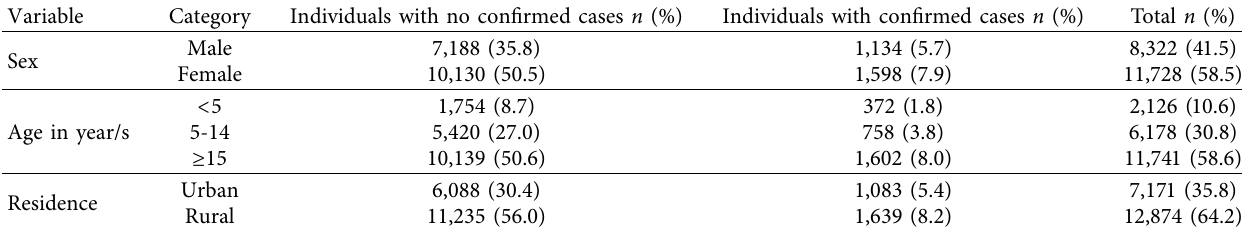
Table 1: Prevalence of malaria in relation to demographic variables from record